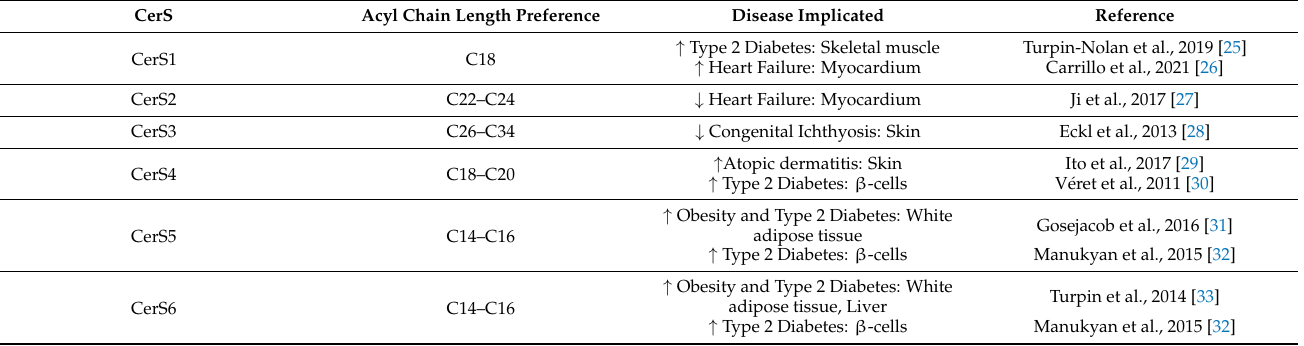
Table 1. The different ceramide synthases (CerS) characterized to date, their substrate preferences, and their associations with different